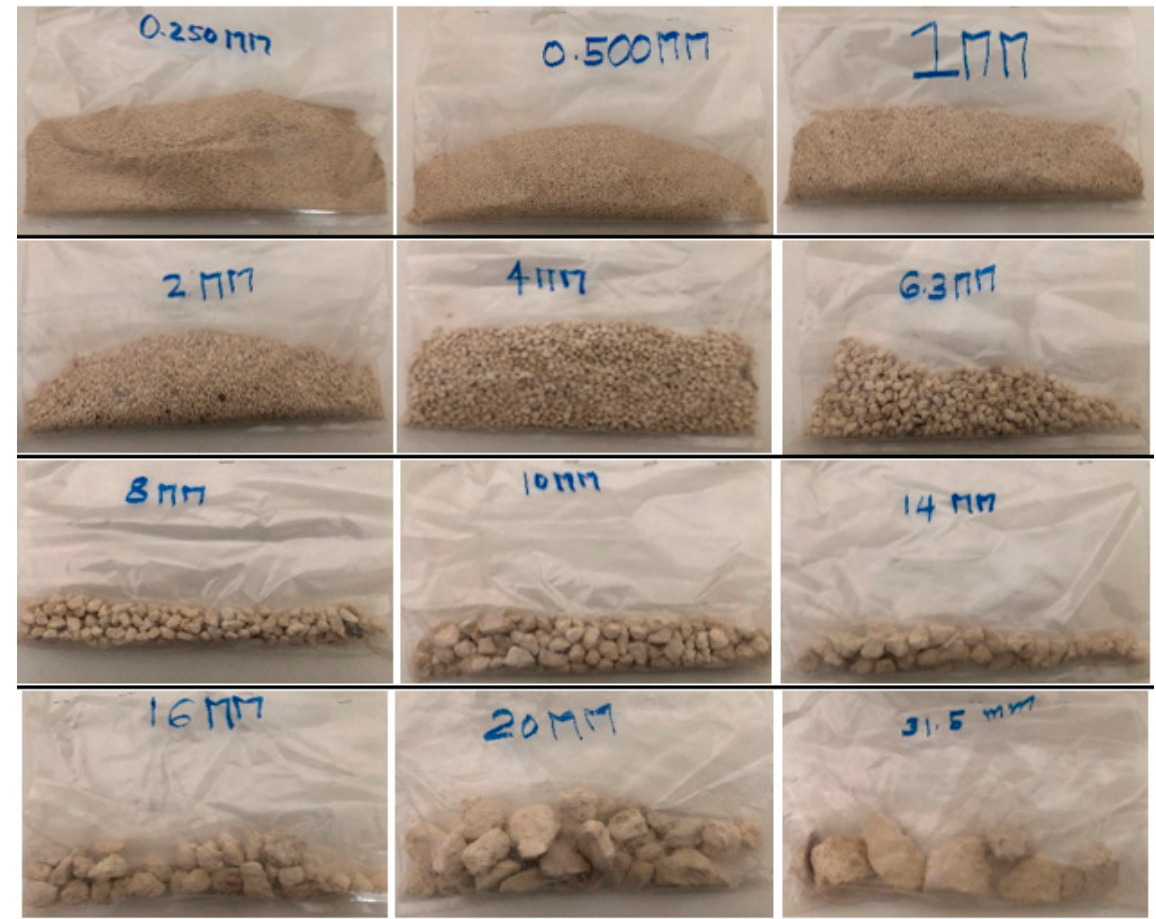
Figure 7. Digital images of TBM muck samples retained on each sieve during sieve analysis.